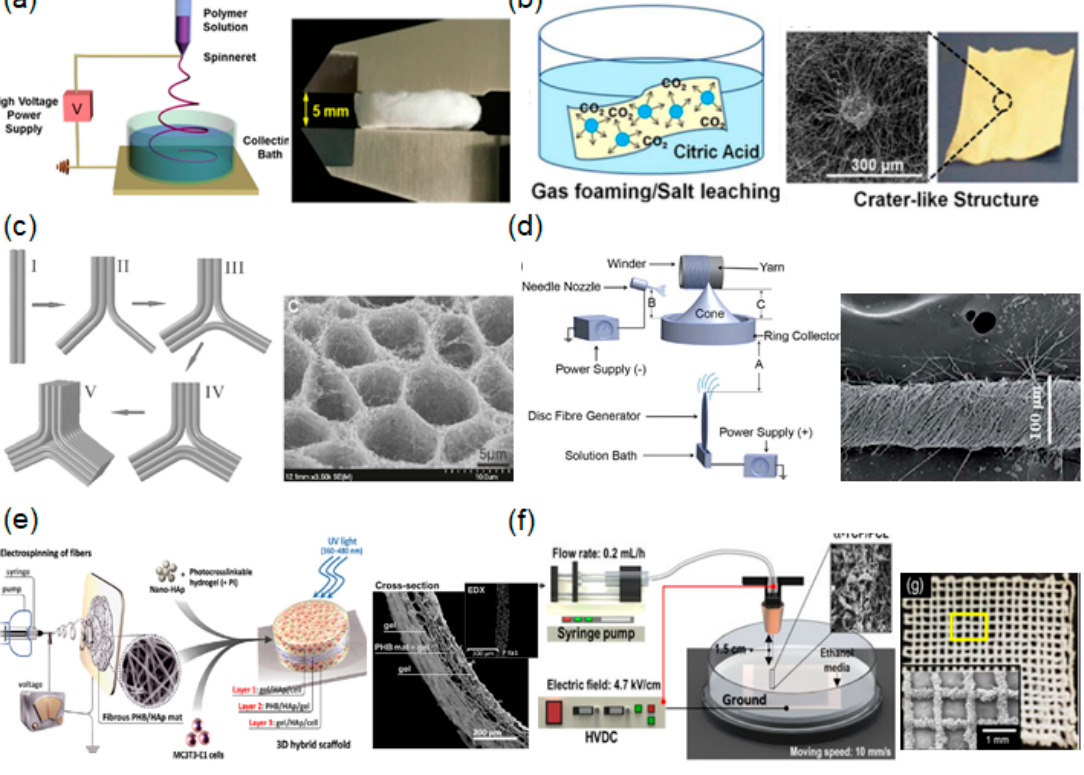
Figure 3. Several approaches to the formation of three-dimensional (3D) fibrous scaffolds using different electrospinning process: ( a ) liquid-collecting electrospinning [62]; ( b ) gas foaming [63]; ( c ) self-assembly [64]; and ( d ) fibrous yarn scaffolds [65]; ( e ) schematic illustration of a hydrogel-integrated fibrous scaffold [66]; ( f ) a hybrid system using 3D printing and electrospinning [67].